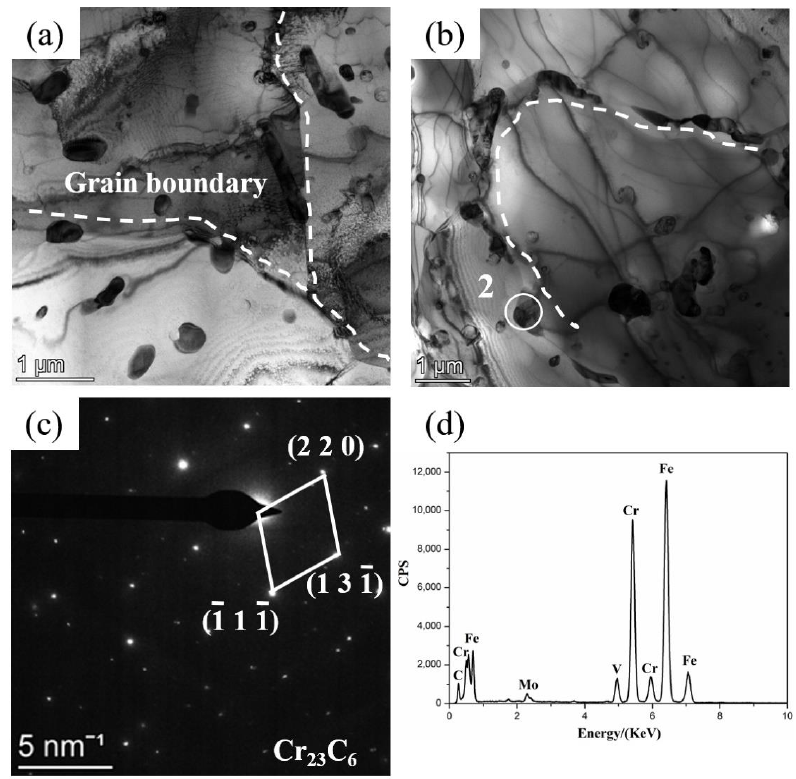
Figure 4. TEM micrographs of carbides in ( a ) H13 and ( b ) RE‐H13 die steels, ( c ) SAED patterns of carbides along grain boundaries, ( d ) EDS analysis of Cr 23 C 6 precipitates after annealing. Metals 2020 , 10 , x FOR PEER REVIEW